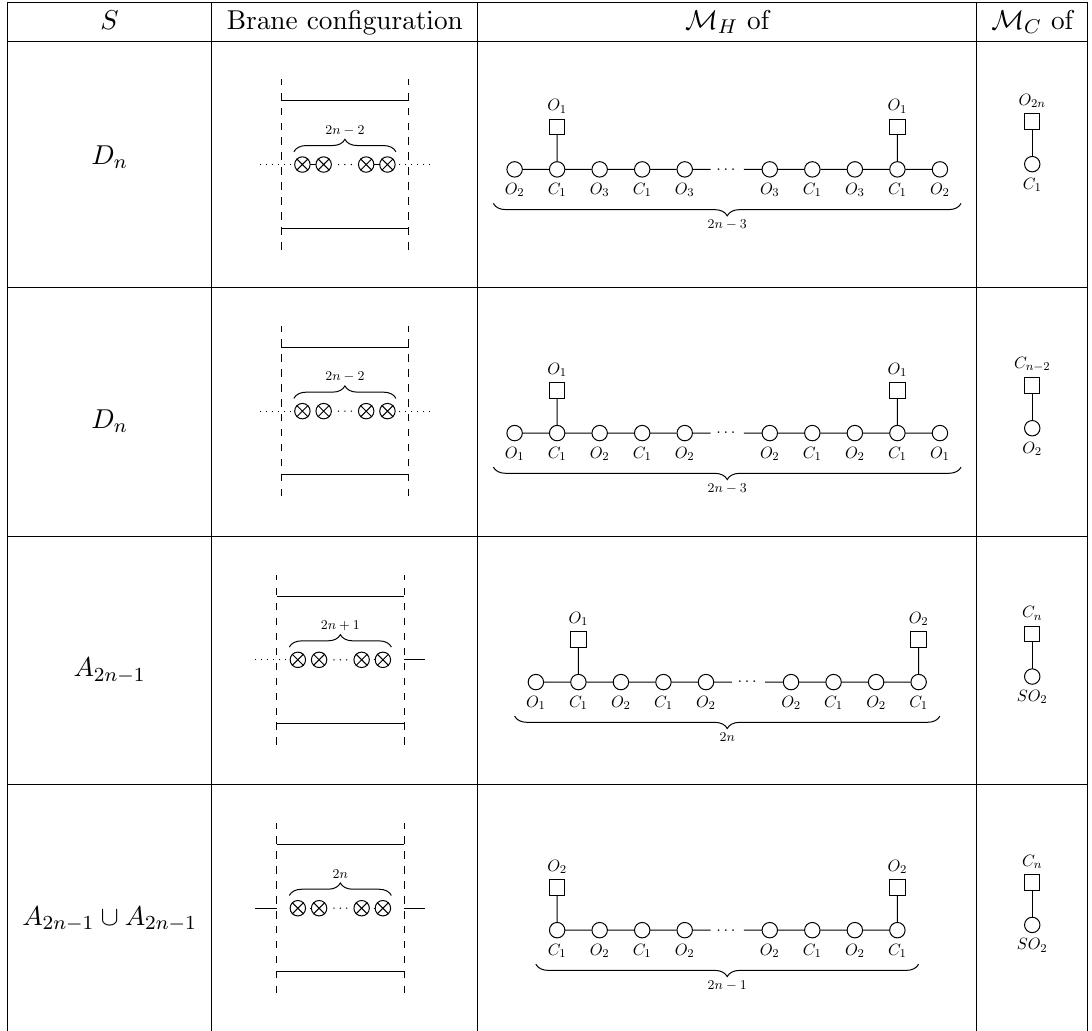
Table 6. Surface KP singularities S and their brane con(cid:12)gurations. The second column shows their brane systems as Higgs branches. The third column shows the quivers obtained from the brane con(cid:12)gurations in the second column. The fourth column shows the quivers obtained after performing S-duality on the second column. Note that the quiver in the fourth column of the fourth row does not have M C = A 2 n (cid:0) 1 [ A 2 n (cid:0) 1 but rather M C = A 2 n (cid:0) 1 , following an e(cid:11)ect